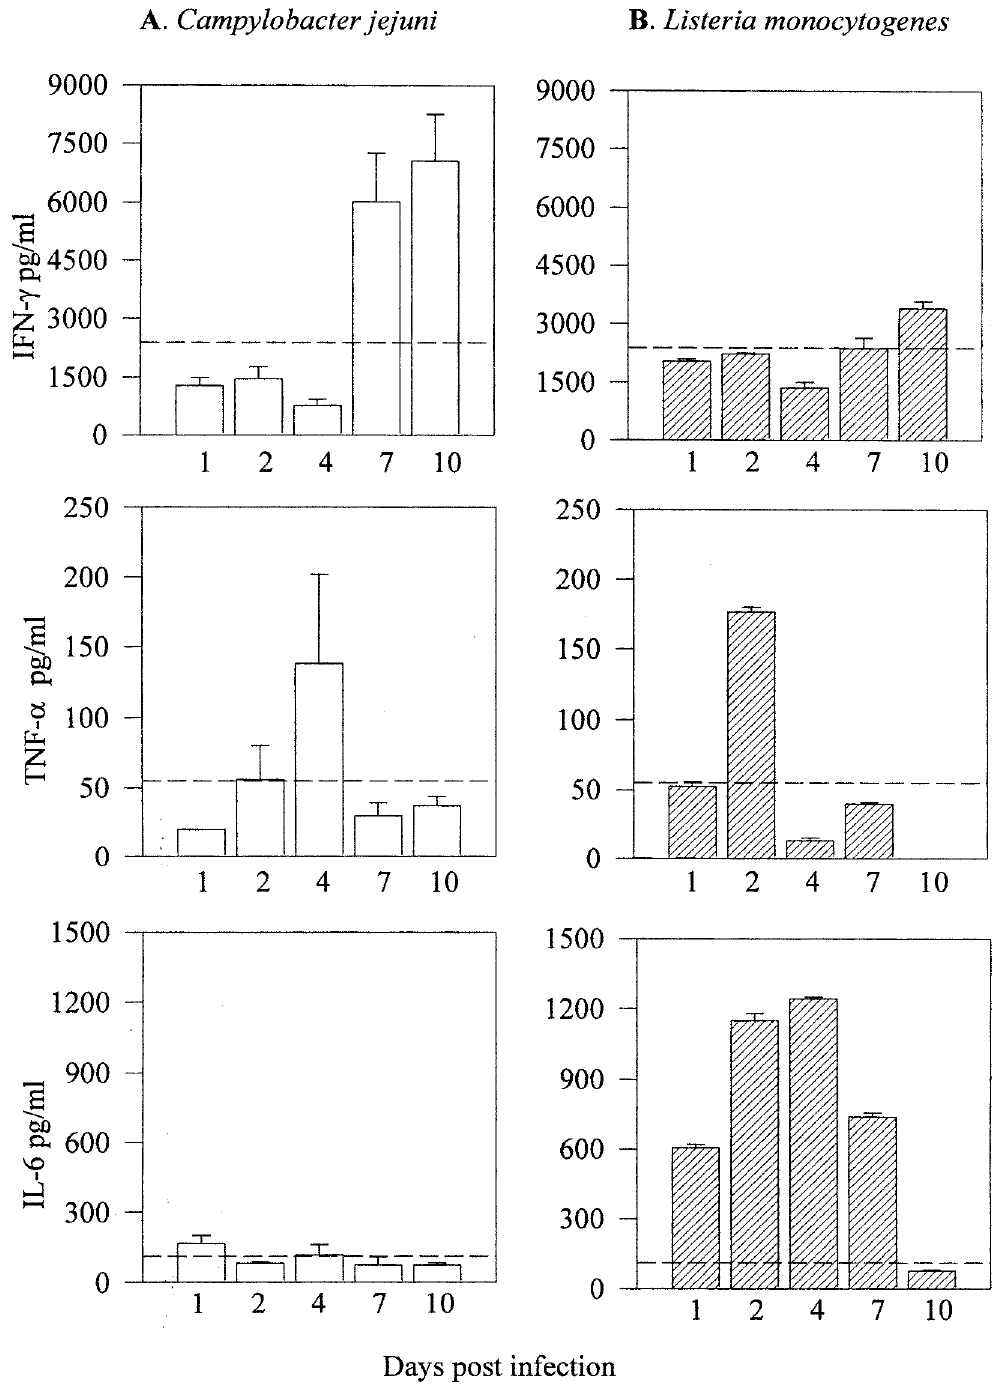
FIG. 2. The levels of IFN- g , TNF- a and IL-6 in the plasma of C57BL/6 mice at different time points after intraperitoneal infection with 0.5–1 ´ 10 9 C. jejuni (A) or 0.5–1 ´ 10 6 viable L. monocytogenes (B). Data are expressed as mean values ± SEM pg/ml. The basal values (dashed line) in non-infected, control mice were: IFN- g = 2382.6 ± 703.21pg/ml; TNF- a = 55 ± 20.02pg/ml and IL-6 = 110.6 ± 18.52pg/ml. Significance: IFN- g ( C. jejuni ) day 7 vs. 4 ( P < 0.005); TNF- a ( L. monocytogenes ) day 2 vs. 1 and 4, day 7 vs. 10 ( P < 0.001); ( L. monocytogenes vs. C. jejuni ) day 1 ( P < 0.0001); IL-6 ( L. monocytogenes ) day 2 vs. 1 ( P < 0.005), day 7 vs. 10 ( P < 0.001); ( L. monocytogenes vs. C. jejuni ) day 1 ( P < 0.001), day 2, day 4, day 7 ( P <